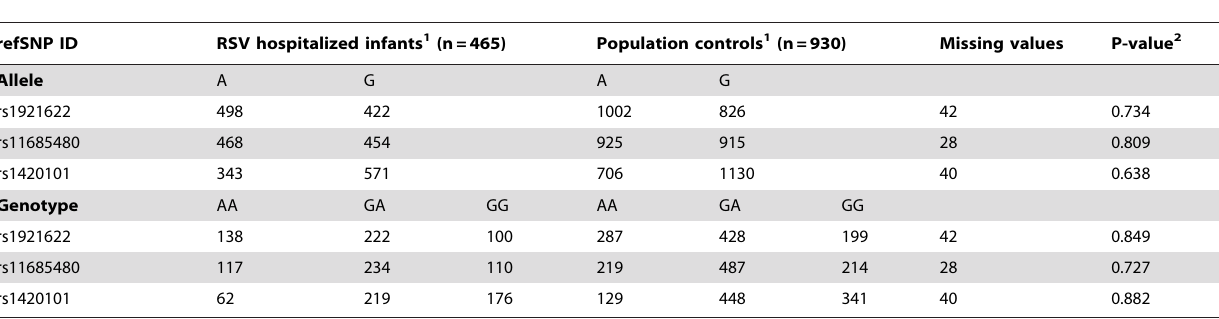
Table 1. IL1RL1 SNPs not associated with RSV bronchiolitis.